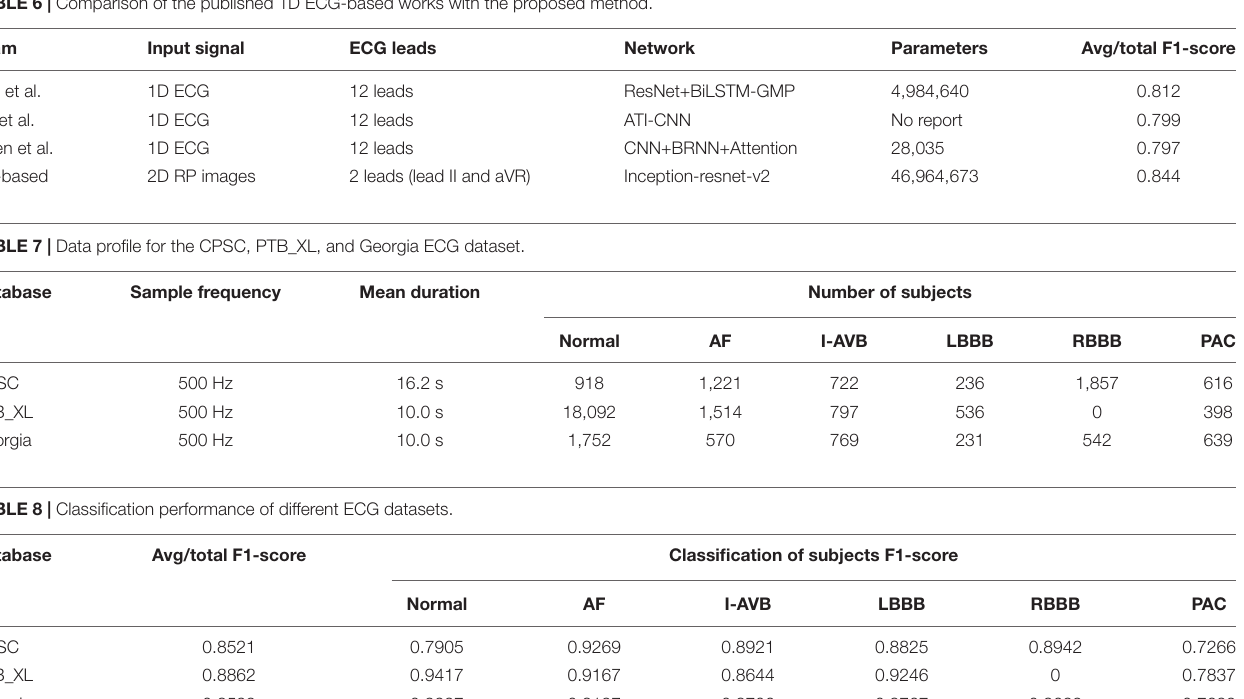
TABLE 6 | Comparison of the published 1D ECG-based works with the proposed method.